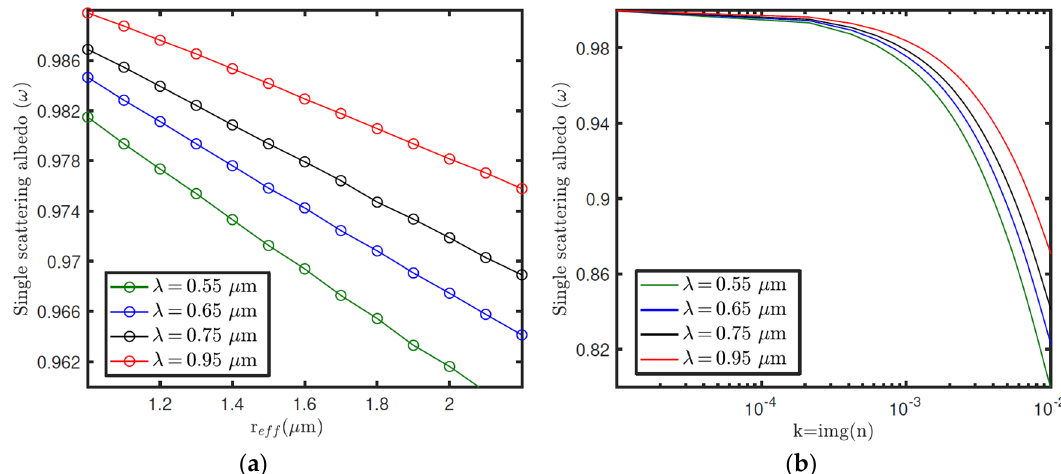
Figure 19. ( a ) Phase functions of equal cylindrical particles computed at 0.75 µm for a set of r eff values and a constant v eff = 0.3. ( b ) Variation of the equal-cylindrical-particle extension cross-section with r eff at 0.75 µm for a set of v eff values.